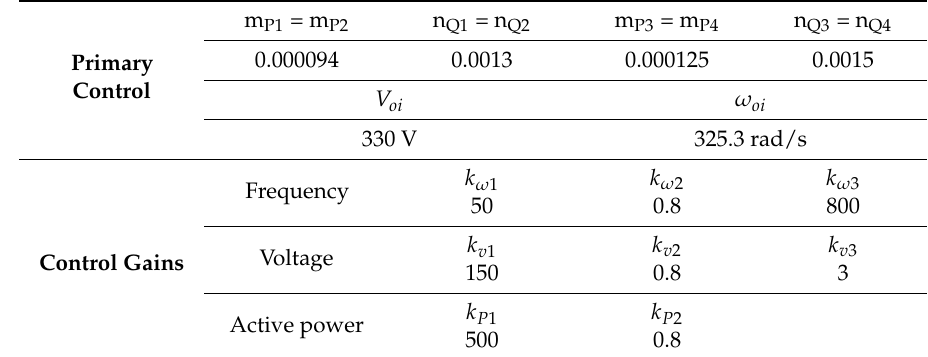
Table 2. Droop parameters and synergetic control gains.